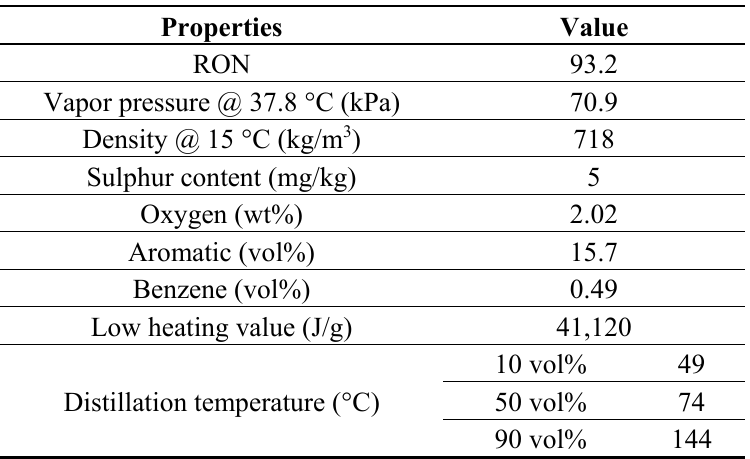
Table 2. Properties of the gasoline fuel.